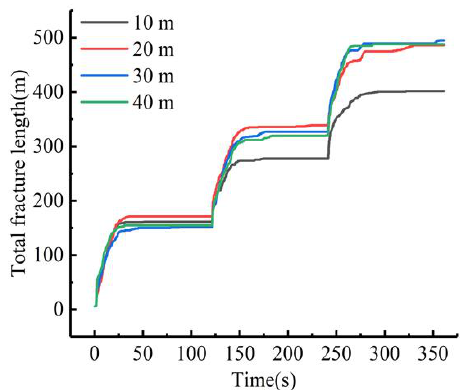
Figure 24. Variation curves of the total fracture length of segmented fractures in CBM reservoirs with various fracturing intervals.